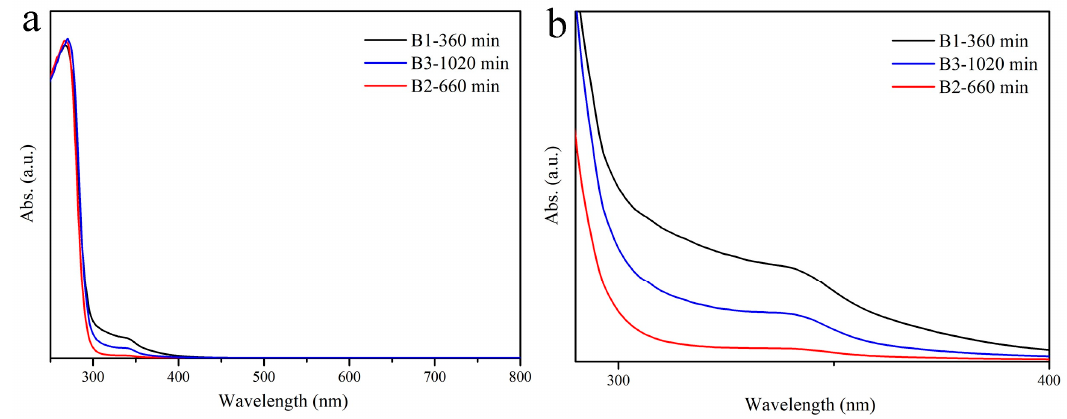
Figure 1. ( a ) absorption spectrum of Cs 2 SnCl 6 crystal doped with Ce at different reaction times; ( b ) samples of B1, B2, B3 Magnified absorption spectrum of 300–400 nm.